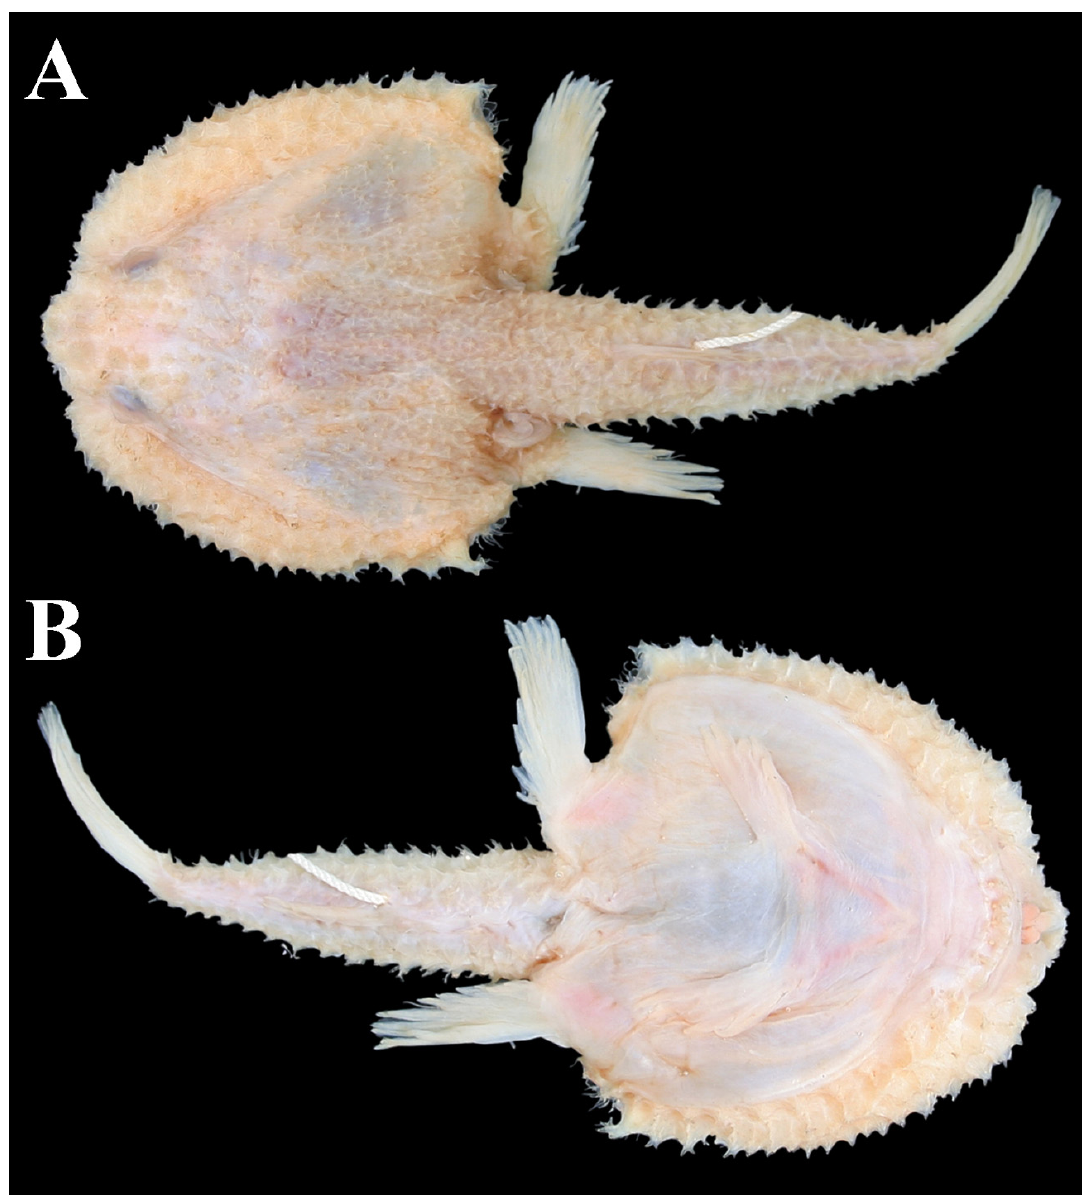
Figure 29. Halieutopsis okamurai sp. nov., holotype, BSKU 19899, 65.0 mm SL. ( A ). Dorsal view. ( B ). Ventral